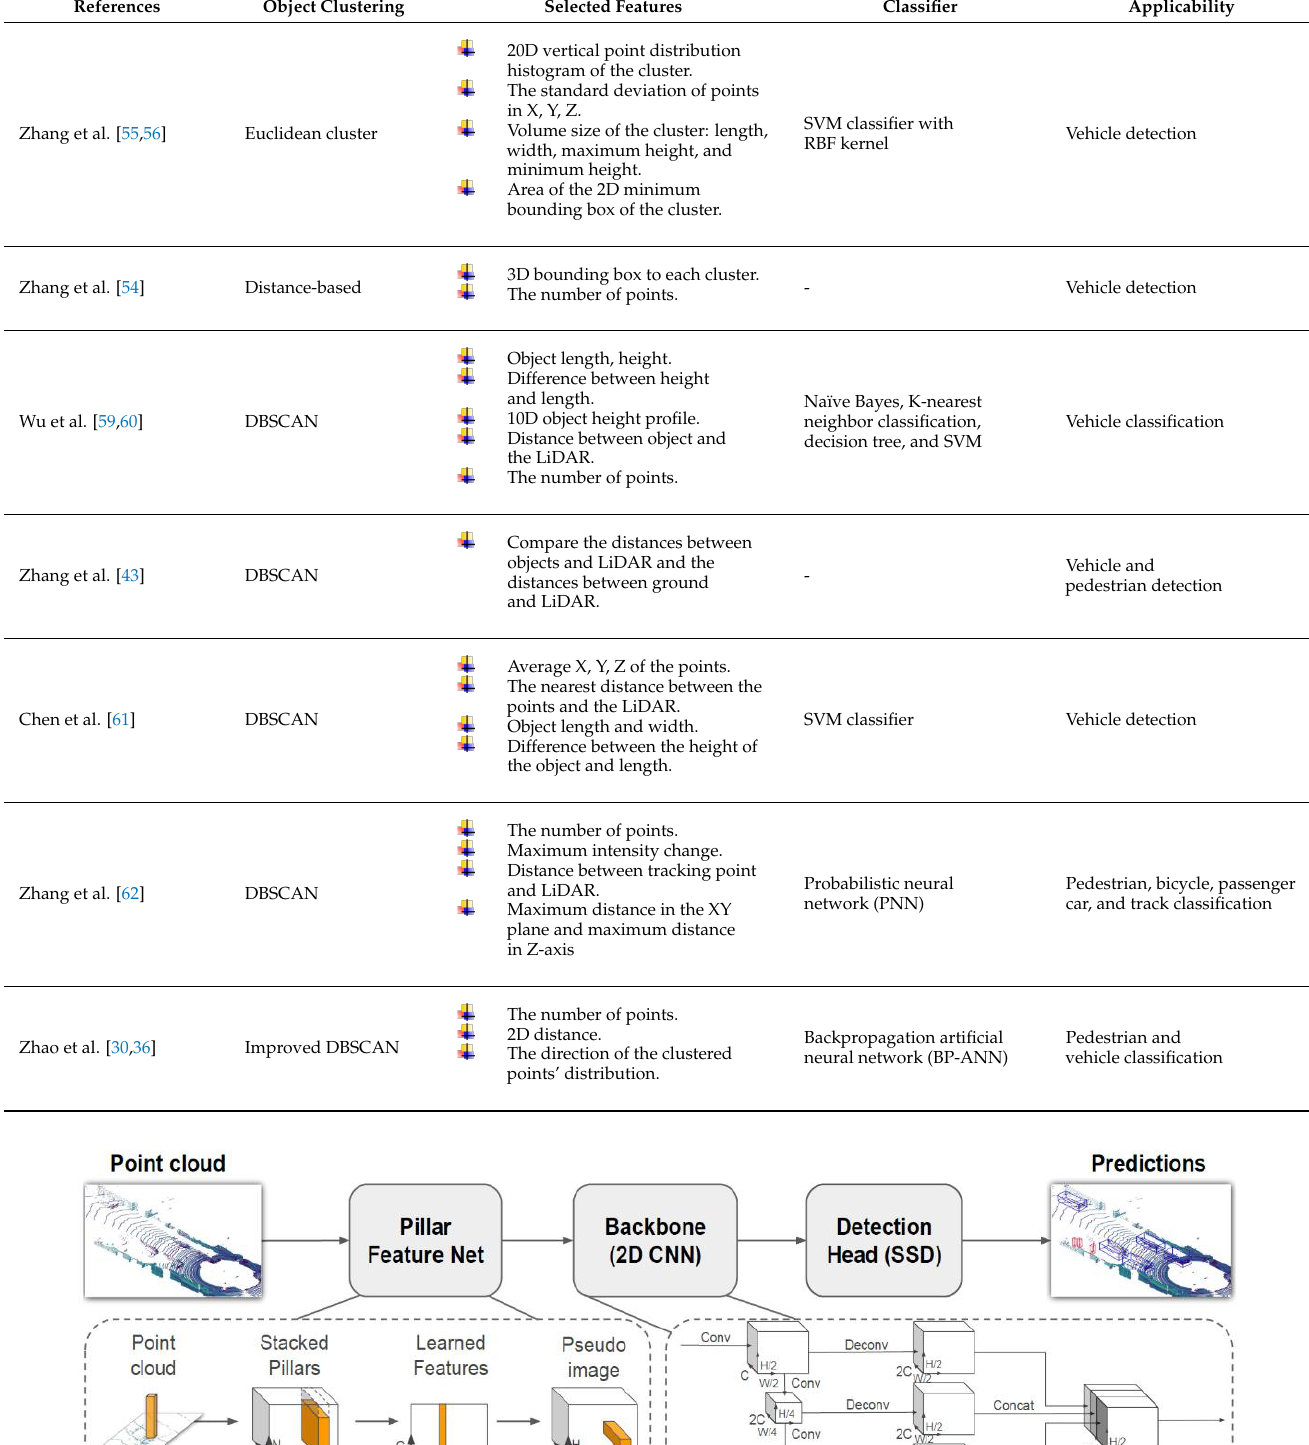
Table 3. Summary of the features used for LiDAR data classification.